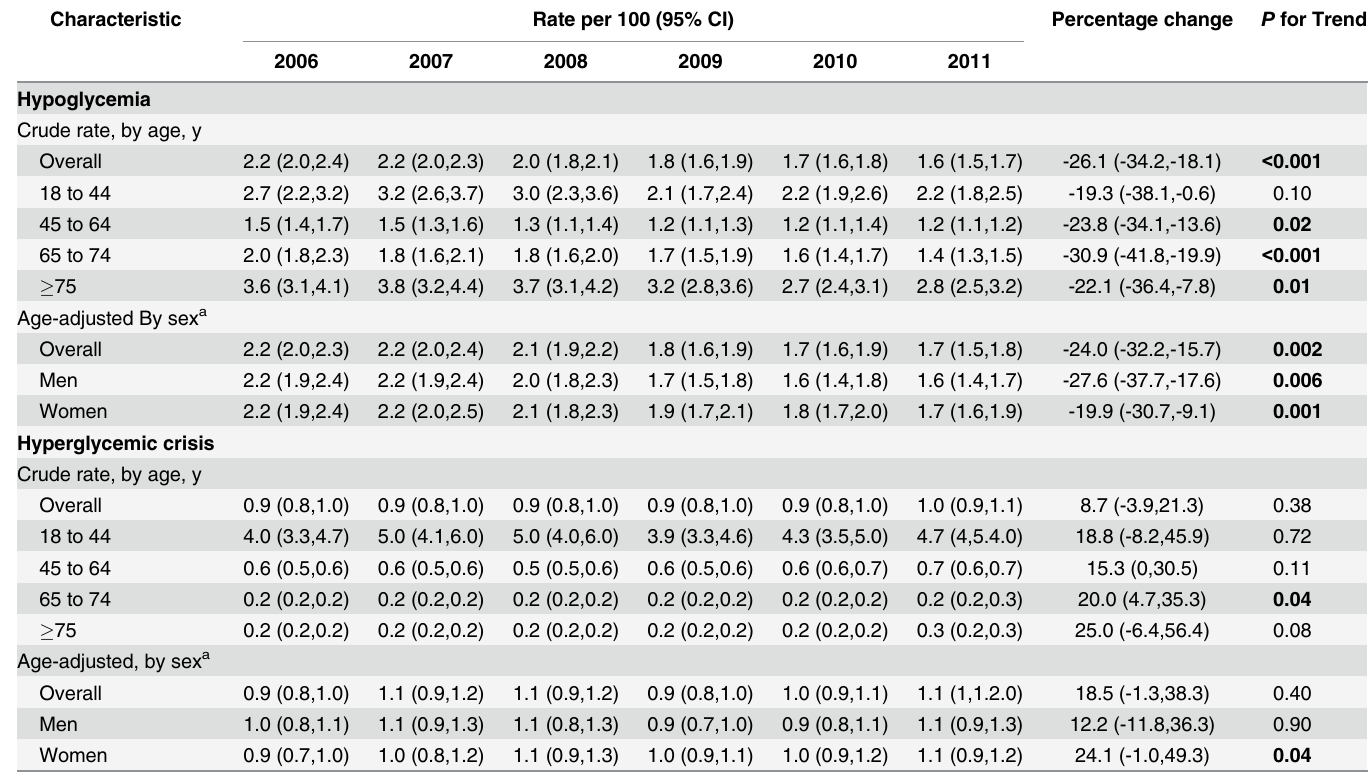
Table 3. Emergency Department Visit Rates for Hypoglycemia and Hyperglycemic Crisis Among Adults With Treated Diabetes 2006 – 2011.